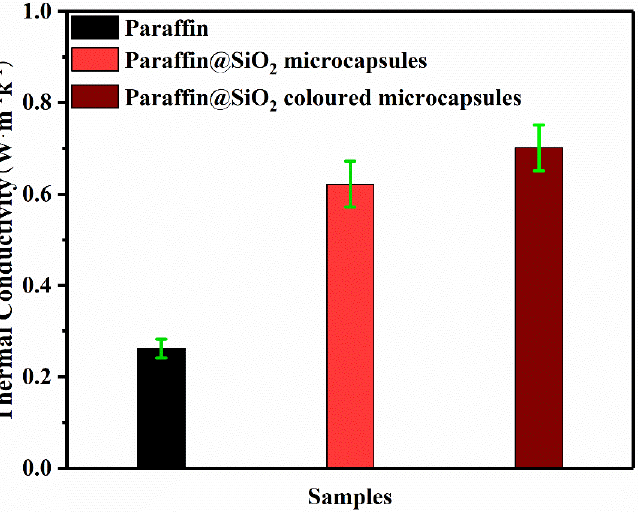
Figure 8 . Thermal conductivity of pristine paraffin, paraffin@SiO 2 microcapsules, the paraffin@SiO 2 colored microcapsules, and SiO 2 nanoparticles.